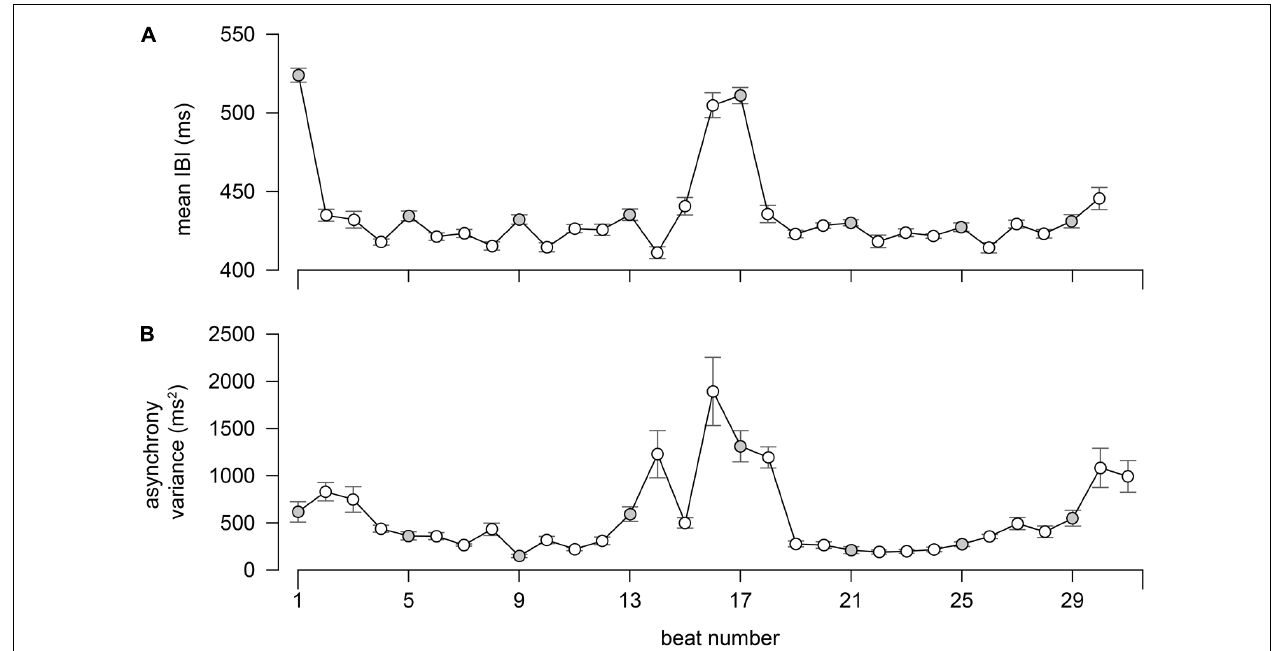
FIGURE 2 |Average IBIs (A) and asynchrony variances (B) of the quartet at each quarter note beat. The error bars represent one standard deviation over repetitions.